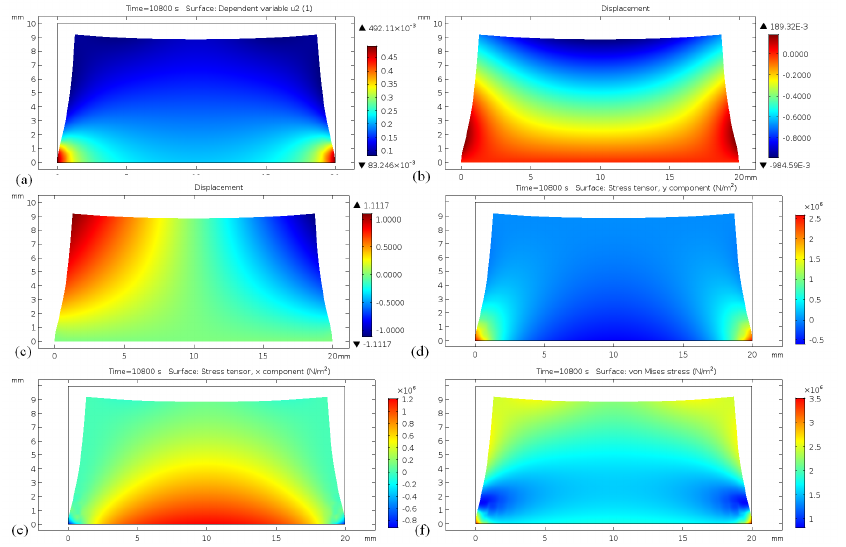
Figure 15. ( a ) Porosity distribution at the end of sintering time; ( b ) vertical displacement; ( c ) horizontal displacement; ( d ) stress distribution S yy . ( e ) S xx ; ( f ) von Mises. The initial poros- ity value is θ 0 = 0.3, η = 1 × 10 11 Pa · s, P L = 1